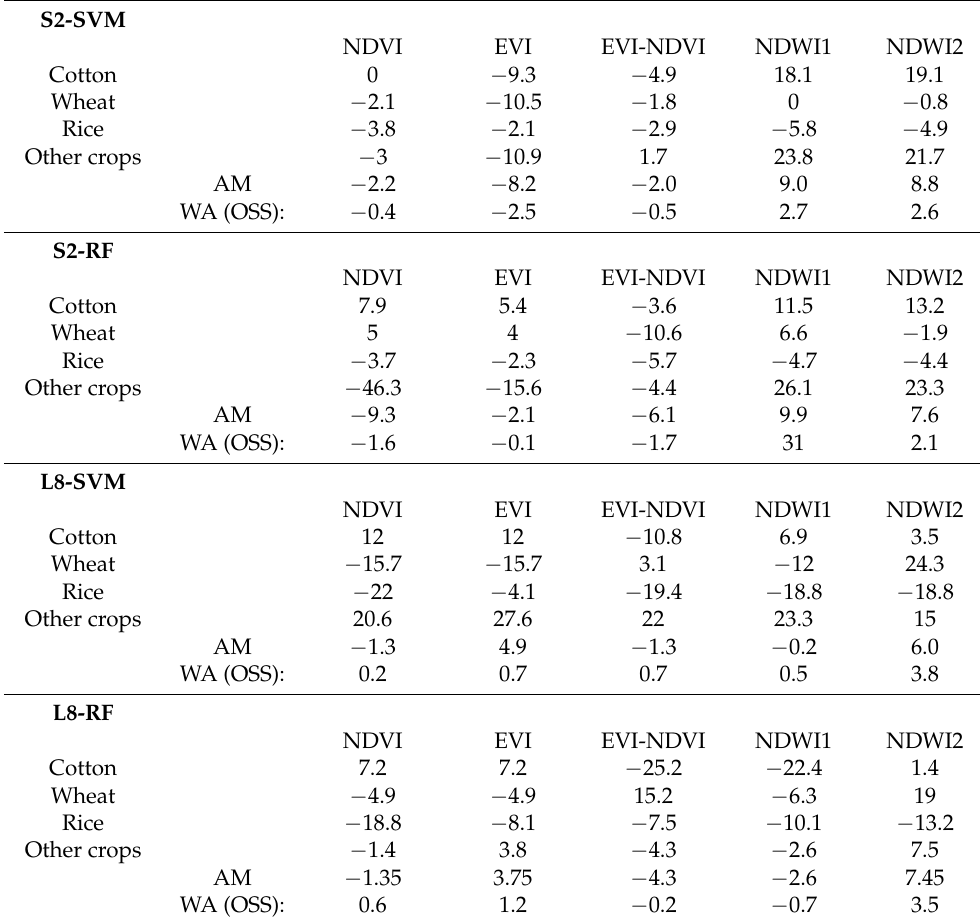
Table 4. Differences between classification results and OSS (1000